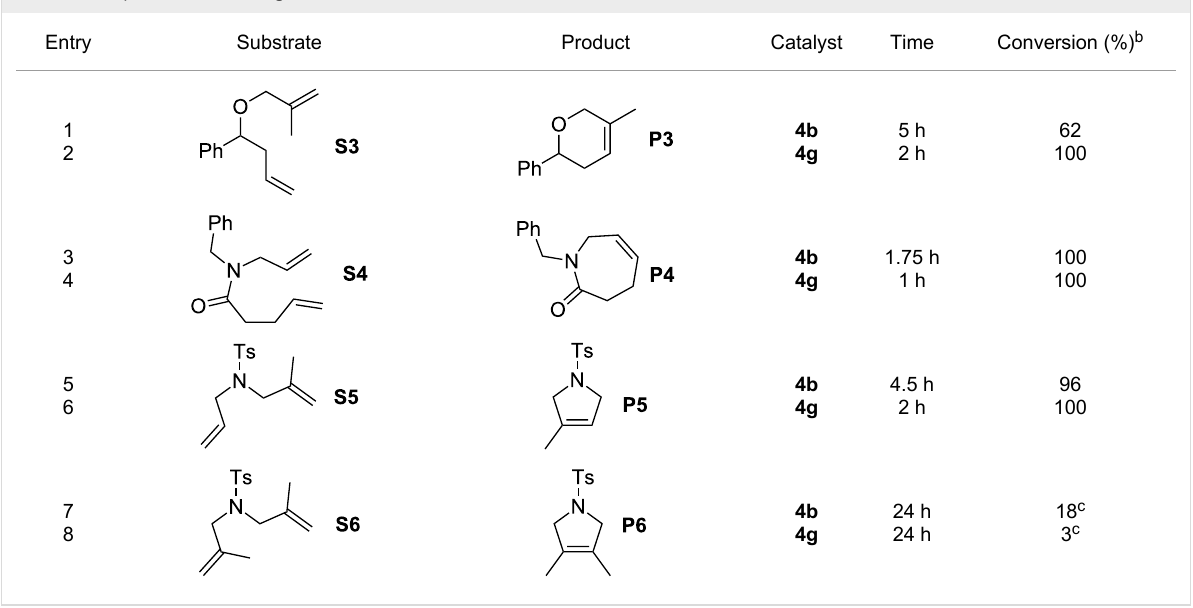
Table 2: Comparison of 4b and 4g in metathesis reactions a